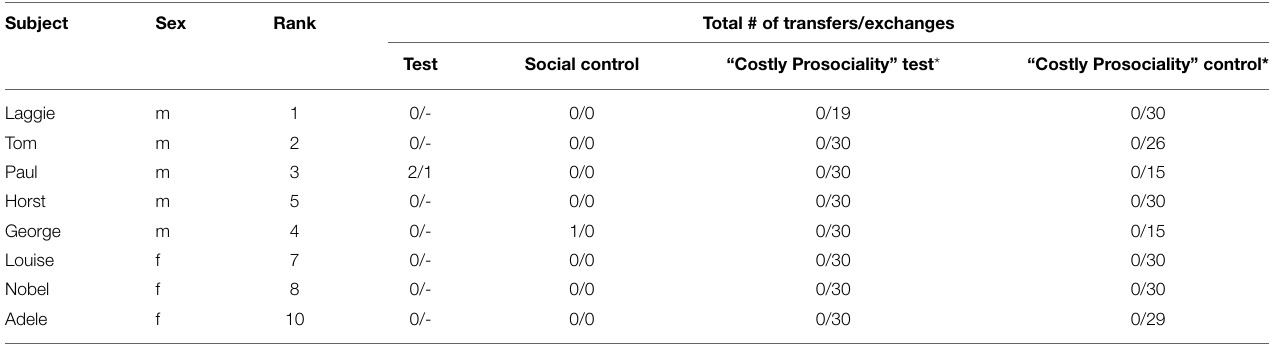
TABLE 2 | Name, sex and rank of subject, and the total number of transfers to the group and subsequent exchanges by a group member (transfers group/exchanges) in the 4 different conditions.